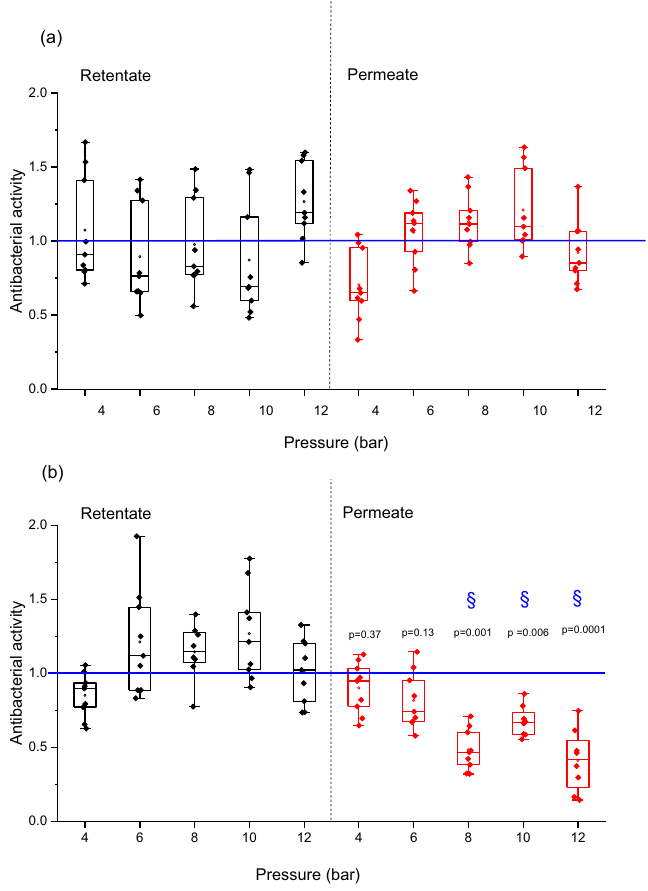
Figure 4. Lysozyme antibacterial activity for retentate (black) and permeate (red) solutions for ( a ) raw (M1 and M2) and ( b ) M1Reg and M2Reg; § represents the significant difference for P < 0.05 with respect to lysozyme reference (untreated lysozyme), blue line represents the lysozyme